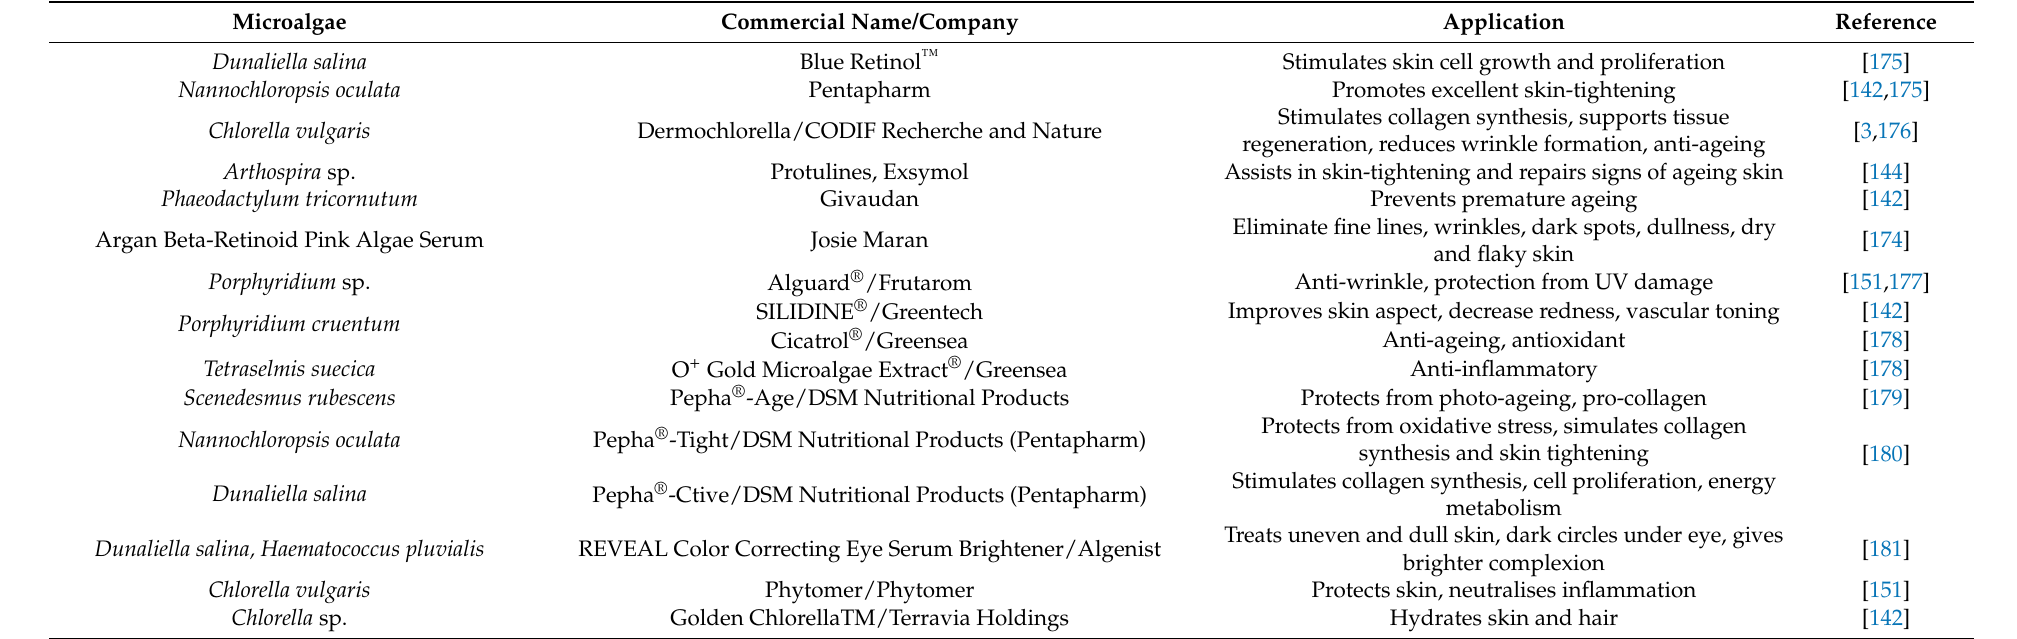
Table 5. Selected representation of the commercialized microalgae-derived cosmetic care